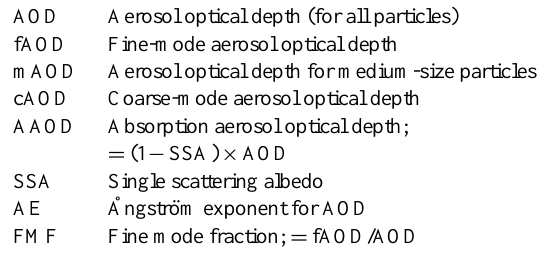
Table 1. Summary of the acronyms.